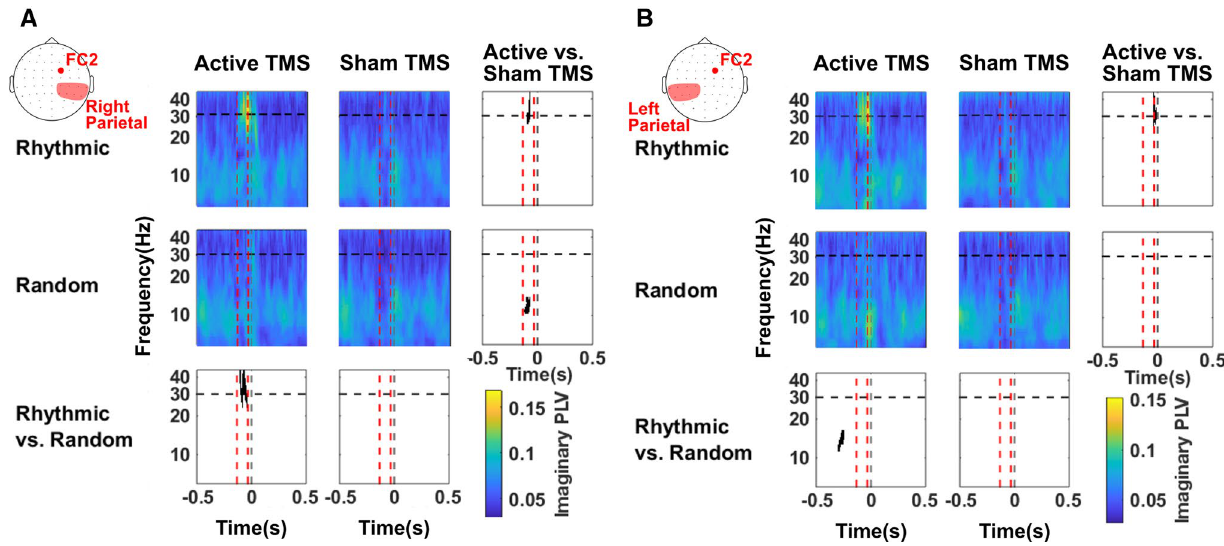
Figure 3. Temporal dynamics and frequency-specificity of fronto-parietal synchronization (imaginary PLV) across stimulation patterns delivered to the right FEF. Time frequency analyses of imaginary Phase-Locking Value (imaginary PLV) between the FC2 scalp EEG electrode and right ( A ) or left ( B ) parietal scalp EEG leads. Time is centered (vertical dotted grey line, t = 0) to the onset of the visual target. Panels are arranged following our 2 × 2 crossed factorial design. We compared sham vs. active TMS condition (rows) and random vs. rhythmic TMS patterns (columns). Vertical dotted red lines signal the time window between the 1st (− 133 ms) and the 4th and last (− 33 ms) TMS pulses of the delivered stimulation patterns. The horizontal dotted black line indicates the frequency of TMS rhythmic stimulation pattern (30 Hz). Bottom and right panels present the outcomes of the statistical permutation tests, with black pixels indicating clusters that reached statistical significance between TMS conditions (p < 0.05) either active/sham rhythmic vs. active/sham random TMS (bottom row) or active rhythmic/random vs. sham rhythmic/random TMS (right column). Note that imaginary fronto-parietal synchrony increased ipsilaterally (right hemisphere) during 30 Hz rhythmic stimulation compared to both random and sham TMS